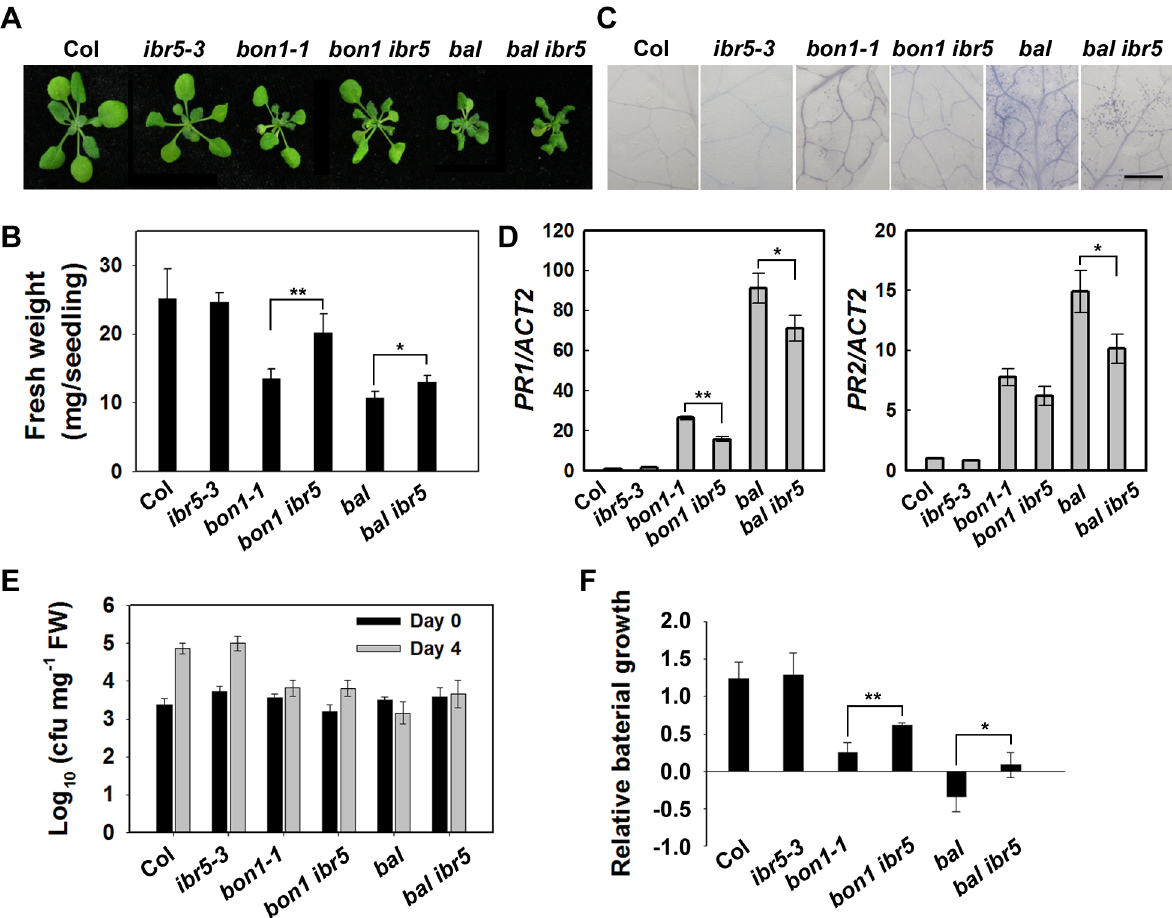
Fig 7. The defense phenotypes of bon1-1 ibr5-3 and bal ibr5-3 . Morphology of 3-week-old Col, ibr5-3 , bon1-1 , bon1-1 ibr5-3 , bal , bal ibr5-3 grown at 22°C. (B) Fresh weight of plants in (A). The error bars represent the SD of three replicates, and the asterisks indicate significant differences ( ** P < 0.01, * P < 0.05, t -test). (C) Trypan blue staining of leaves from the plants described in (A). Bar: 0.5 mm. The expression of PR genes in plants in (A). The error bars represent the SD of three replicates, and the asterisks indicate significant differences ( ** P < 0.01, * P < 0.05, t -test). (E) The effect of IBR5 on pathogen resistance of bon1-1 and bal to P . s . t . DC3000. Three-week-old seedlings were dipped with P . s . t . DC3000 (OD 600 = 0.05), and leaves were taken immediately (day 0) and at day 4 after infection. The log-transformed values presented are the mean values of three replicates ± SD. The experiments were performed three times with similar results. (F) Relative bacterial growth of plants in (E) after infection with P . s . t . DC3000. The values are the ratios of bacteria number at day 4 to day 0. The error bars represent the SD of three replicates, and the asterisks indicate significant differences ( ** P < 0.01, * P < 0.05, t